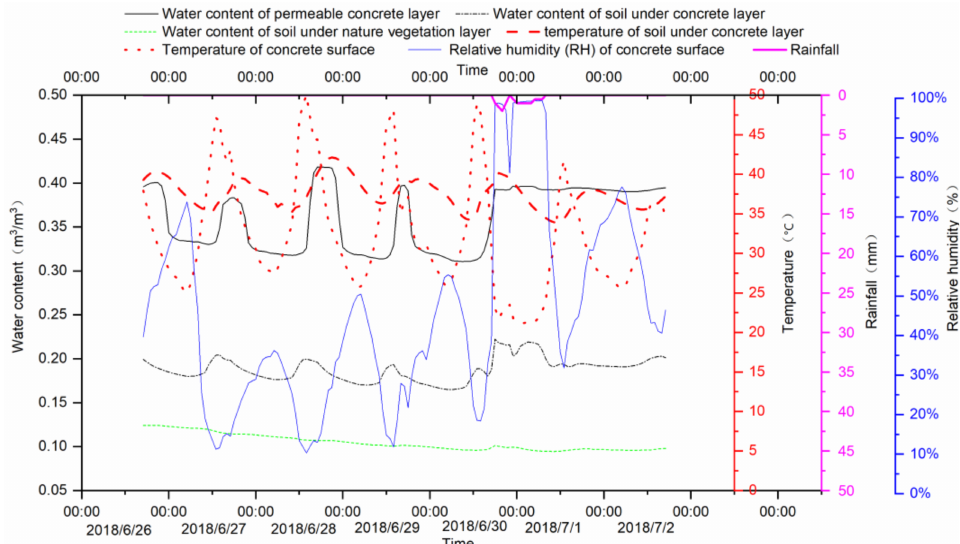
Figure 8. Monitoring results of permeable concrete pavement in the comparison of native vegetation